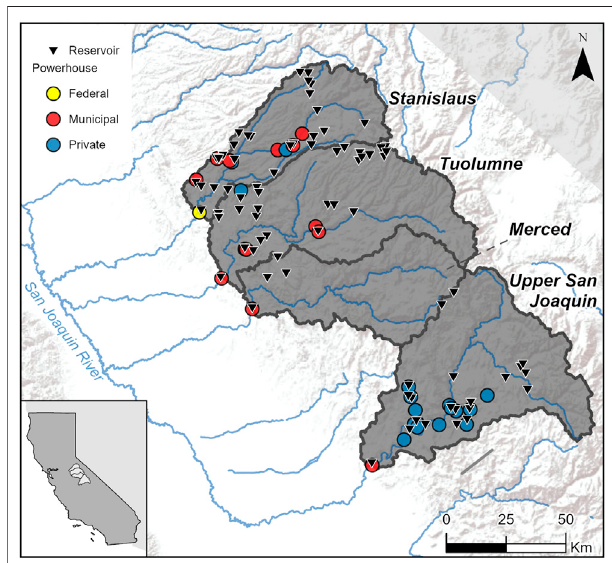
FIGURE 1 | Map of the study area including the four river basins: Stanislaus, Tuolumne, Merced, and Upper San Joaquin rivers. Grey areas show the watershed upstream of each rim